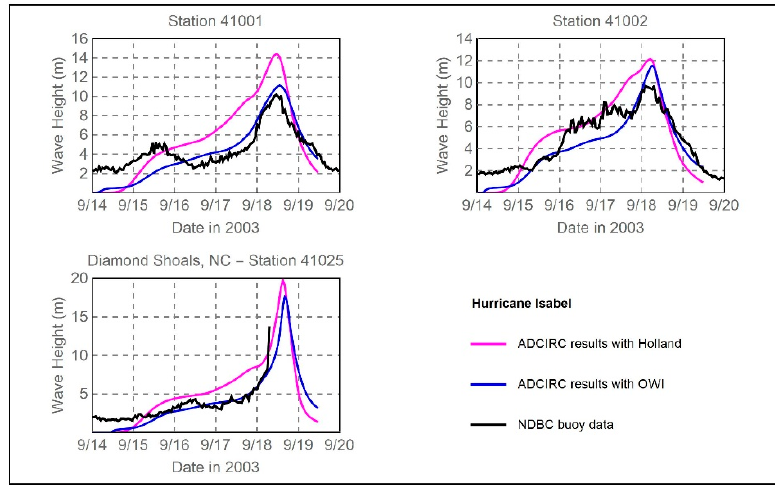
Figure 7. Wave height time series at the NDBC buoys during Hurricane Isabel.